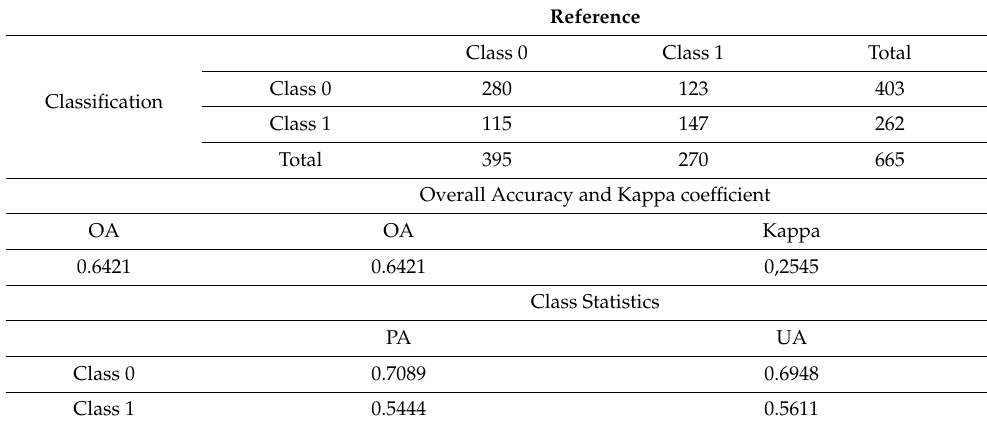
Table A4. CHM classification (“scheme